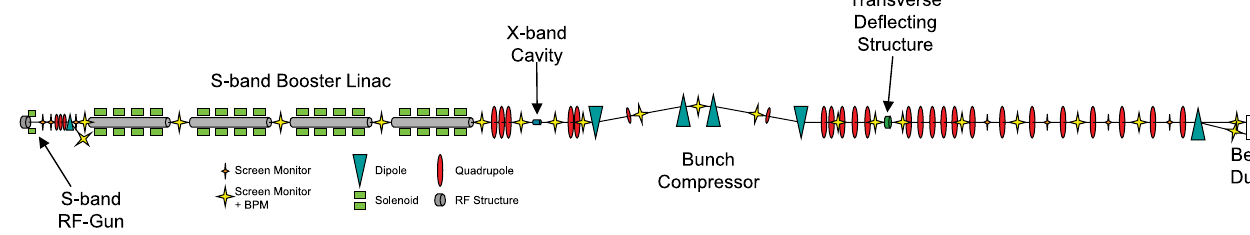
FIG. 2. Schematic layout of the SITF (not to scale). The total length is about 60